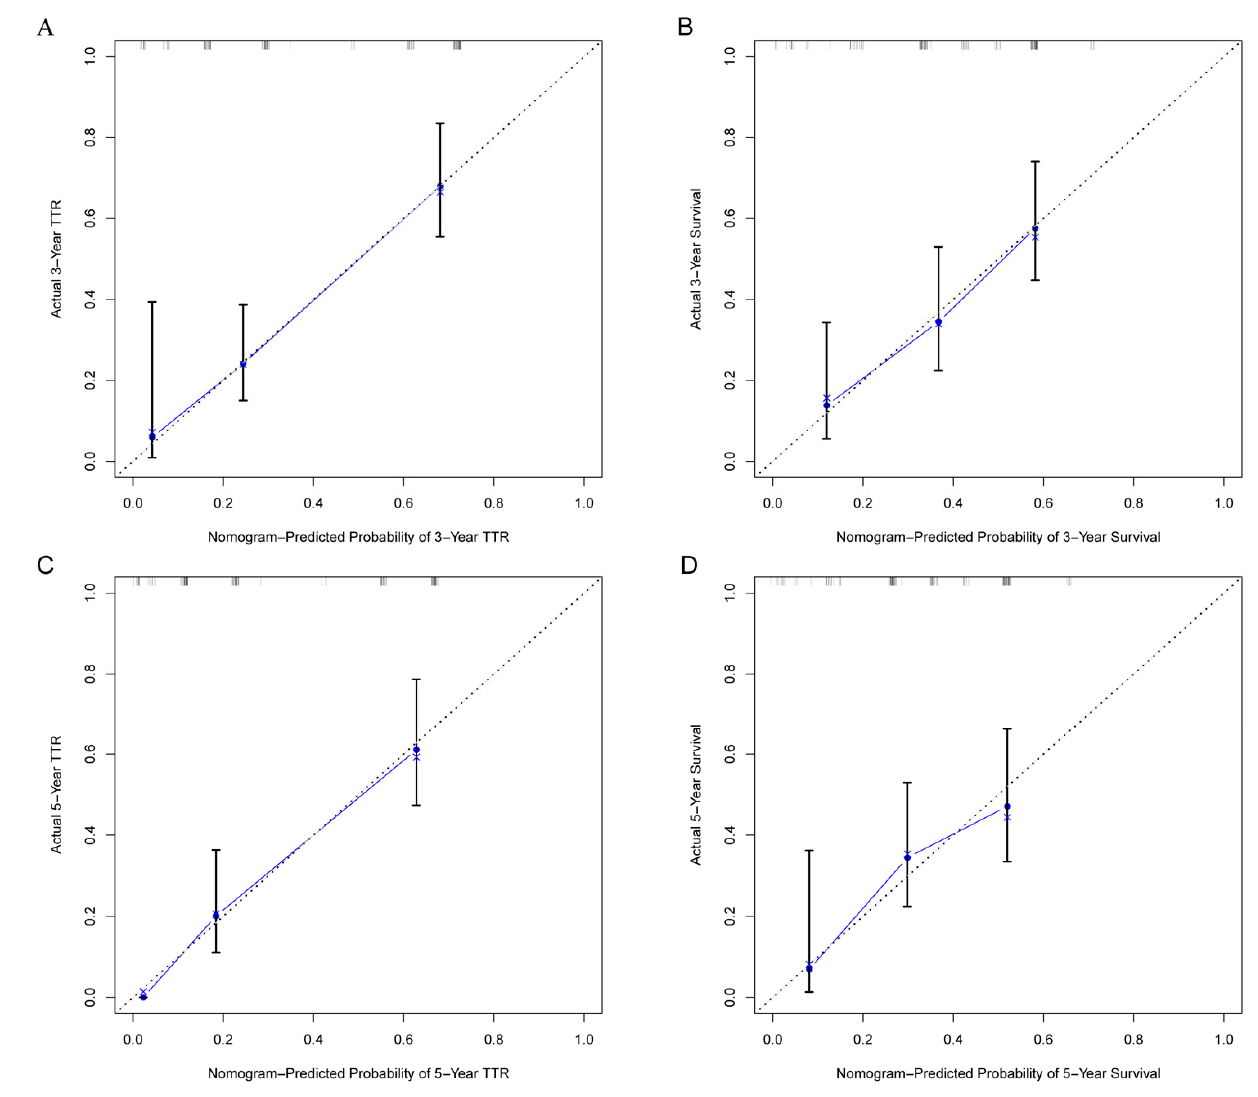
Figure 4. Calibration curves of predicted outcomes and actual outcomes. ( A ) 3-year and ( C ) 5-year TTR nomogram calibration curves; ( B ) 3-year and ( D ) 5-year OS nomogram calibration curves. The 45-degree line represents a perfect match between the nomogram-predicted survival ( X -axis) and actual survival ( Y -axis). The perpendicular line represents 95% confidence intervals of actual survival. The little bars above 1.0 actual values represent numbers of patients in a certain range.